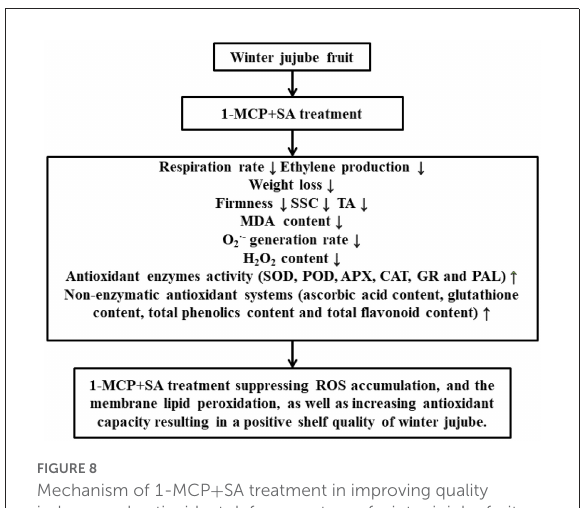
FIGURE8 Mechanism of 1-MCP + SA treatment in improving quality indexes and antioxidant defense system of winter jujube fruit.